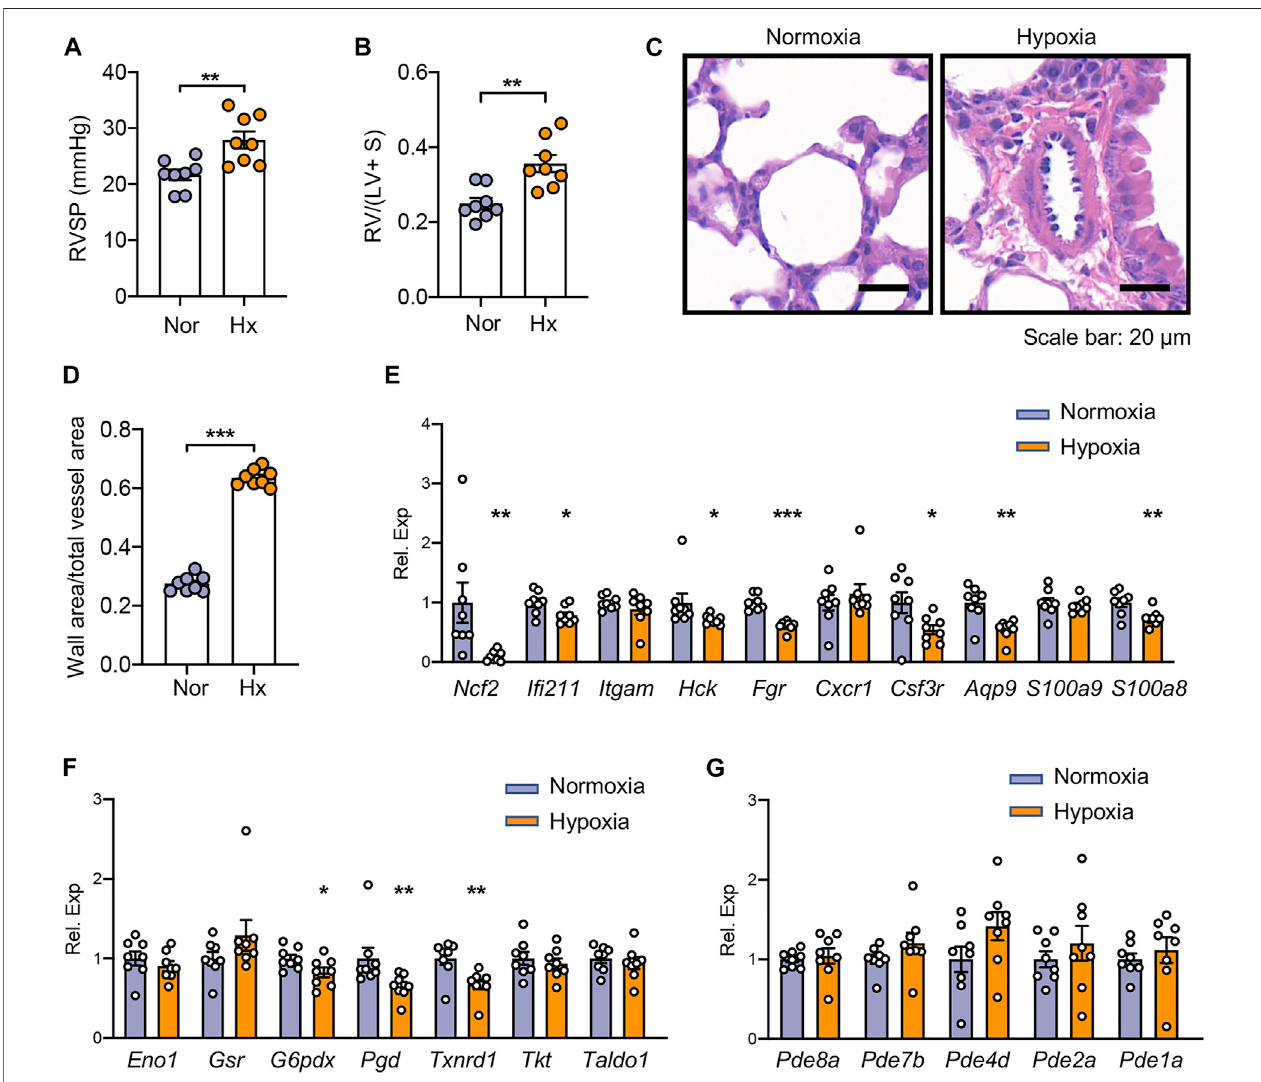
FIGURE 6 | Validation of hub TRGs in mouse lung tissues of hypoxic PH. (A – B) Right ventricular systolic pressure (RVSP) (A) and right ventricular hypertrophy (B) were assessed in hypoxia (Hx)-induced PH mice or mice under normoxia (Nor) at day 28 (n = 8/group). (C – D) Representative images of H&E staining (C) and quanti fi cation of vascular medial thickness (D) of lung tissues from mice under hypoxic or normoxic conditions at day 28 (n = 8/group). (E – G) Gene expression of hub TRGs in the fi rst (left) cluster (E) , in the second (middle) cluster (F) , and in the third (right) cluster (G) of Figure 3B were examined in lungs of hypoxic PH mice and control mice at day 28 (n = 8/group). Data represent mean ± SEM. * p < 0.05; ** p < 0.01; *** p < 0.001 compared to mice under normoxia, as analyzed by the unpaired t -test or Mann – Whitney test as appropriate.